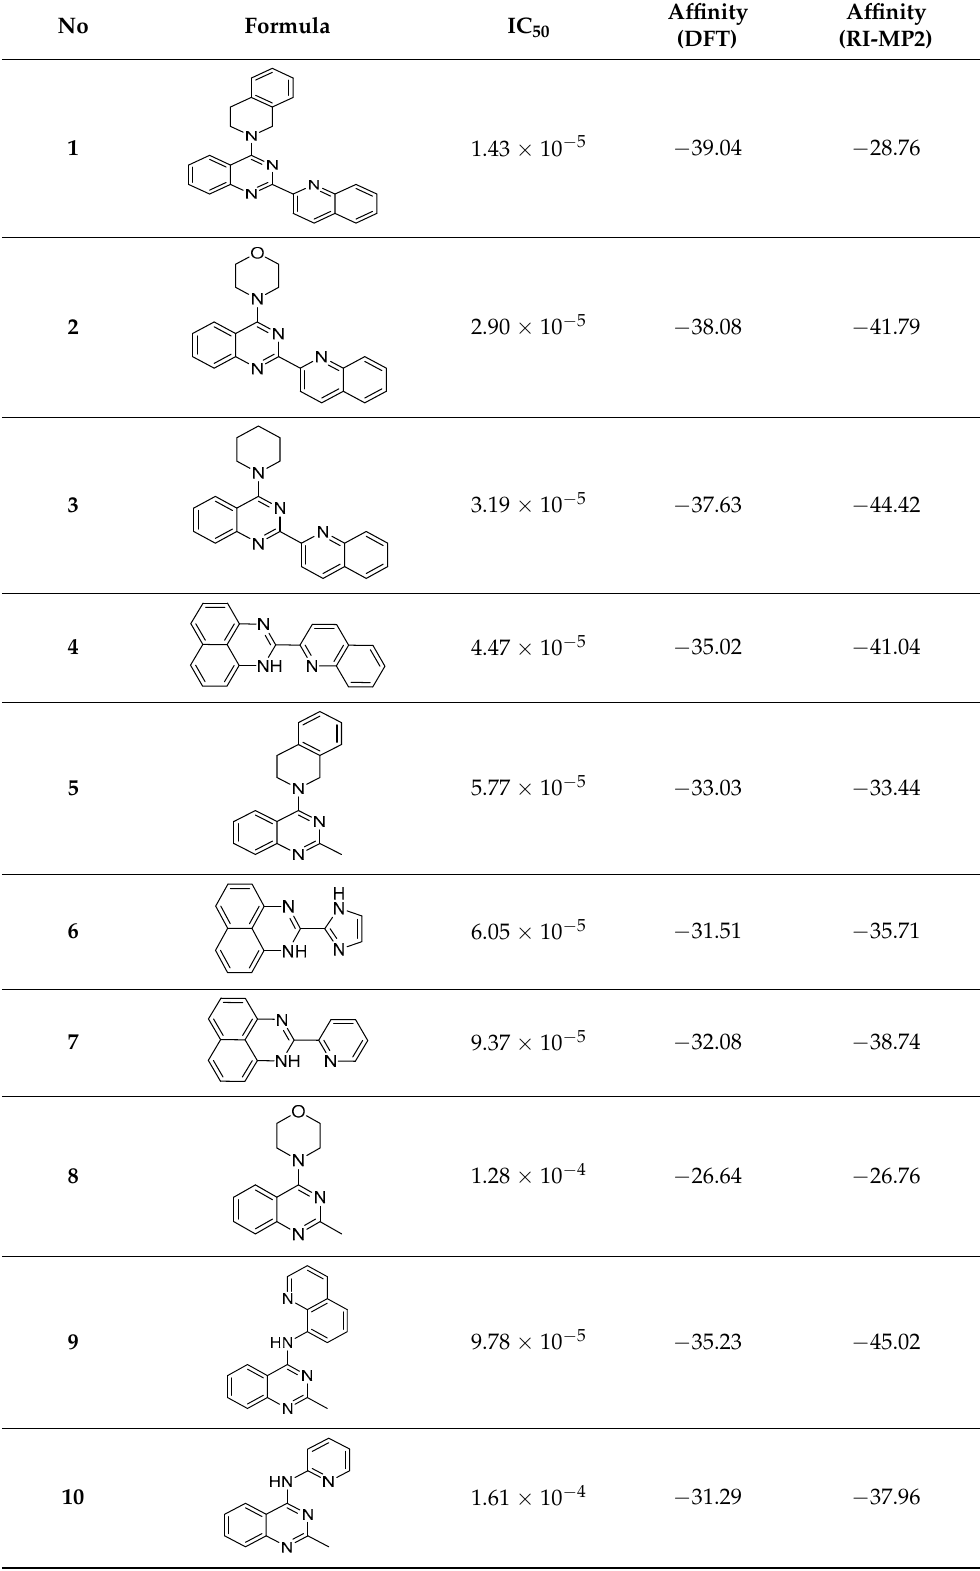
Table 1. Structure of the investigated compounds, experimentally determined IC 50 values, mol, and computed DFT wB97XD/6-31G(d,p)) and RI-MP2/6-31G(d,p)//wB97XD/6-31G(d,p) ligand affinities, kcal · mol − 1 . Full energy data are given in the Supplementary Materials.